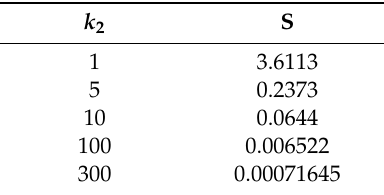
Table 1. The sum of squared residuals of the general case simulations as compared to the special case ( k 1 = 1, K 1 = 10 and K 2 = 10).